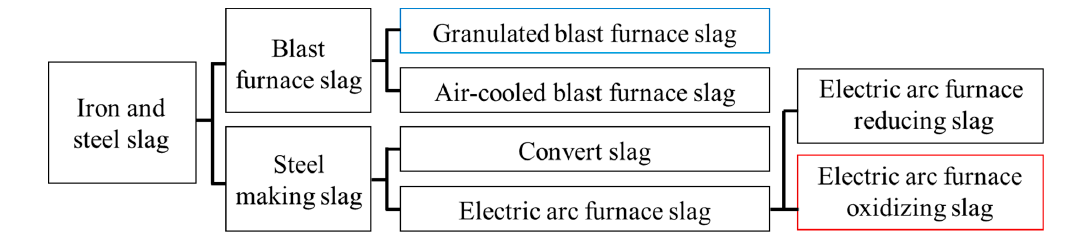
Figure 1. Types of iron and steel slag.